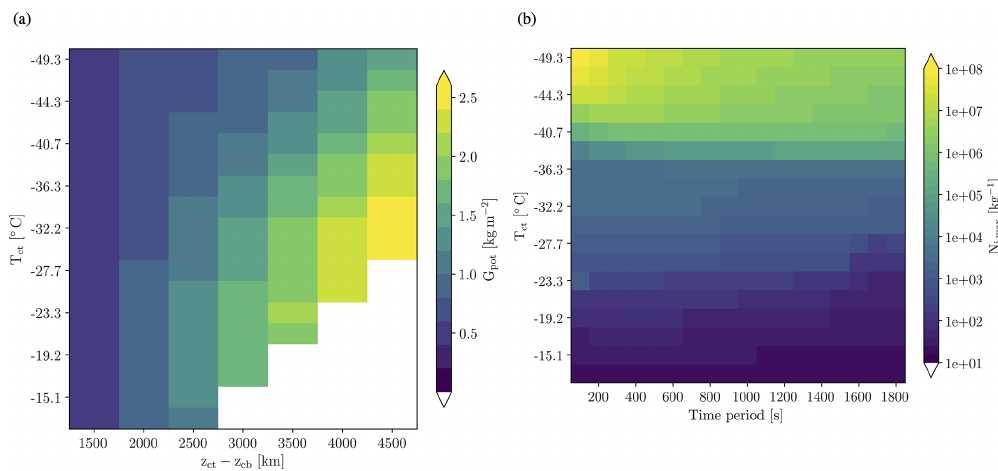
Figure 11. (a) Potential condensate G pot as a function of cloud thickness and cloud top temperature. (b) Maximum ice crystal number concentration n i , max , Lagr as a function of wave period and cloud top temperature for clouds with a thickness of 2km. n i , max , Lagr is the maximum integrated ice crystal formation rate, including homogeneous and heterogeneous freezing, along any trajectory through the wave cloud.